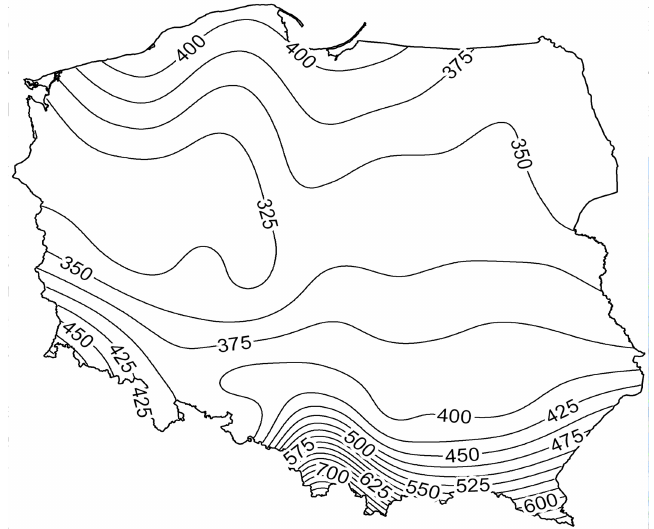
Figure 2. Precipitation (mm) in the growing season (April–September), mean in